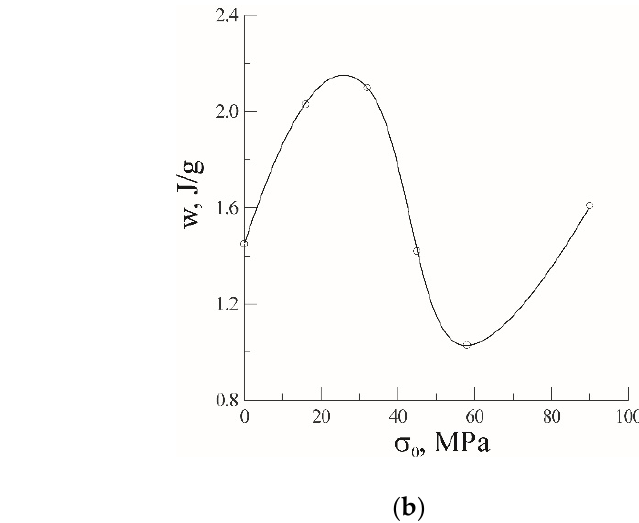
Figure 13. The dependence of microhardness, microstrain ( a ) and excess energy released during DCS scans ( b ) of UFG nickel processed by HPT on the amplitude of UST [30].